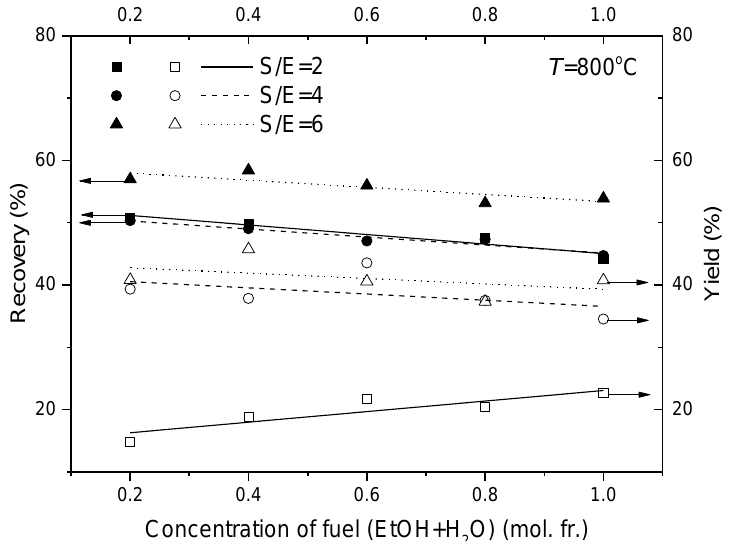
Figure 14. Effect of the concentration of fuel (EtOH + H 2 O) in Ar on the reactor efficiency characteristics. Operating temperature: 800 °C.